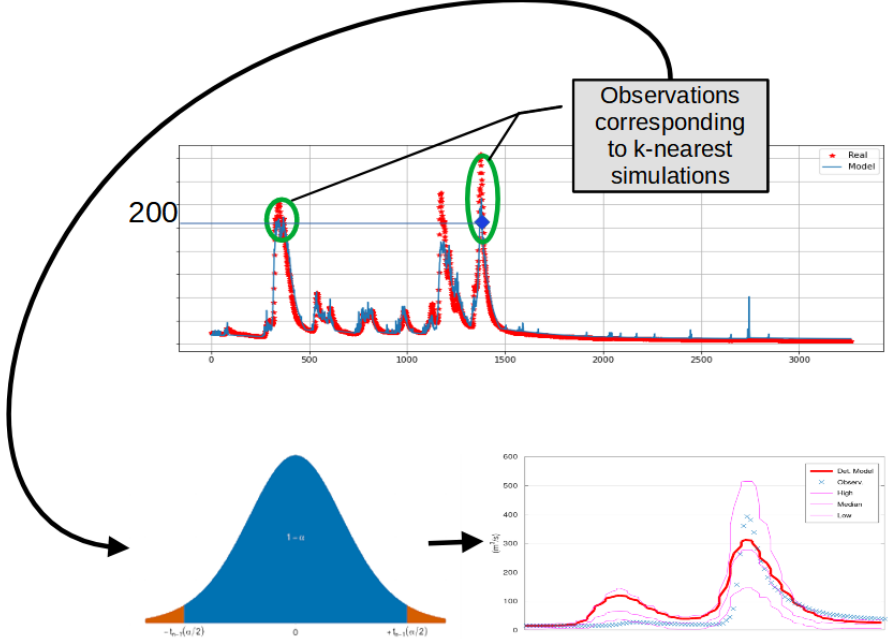
Figure 5. Schematic representation of KNN-Bluecat. The red dots are the observed values during the calibration period. The assessed simulated value during the test period is 200. The empirical distribution of the k observations that correspond to the k nearest to the assessed simulated value (200) gives information regarding the uncertainty of the